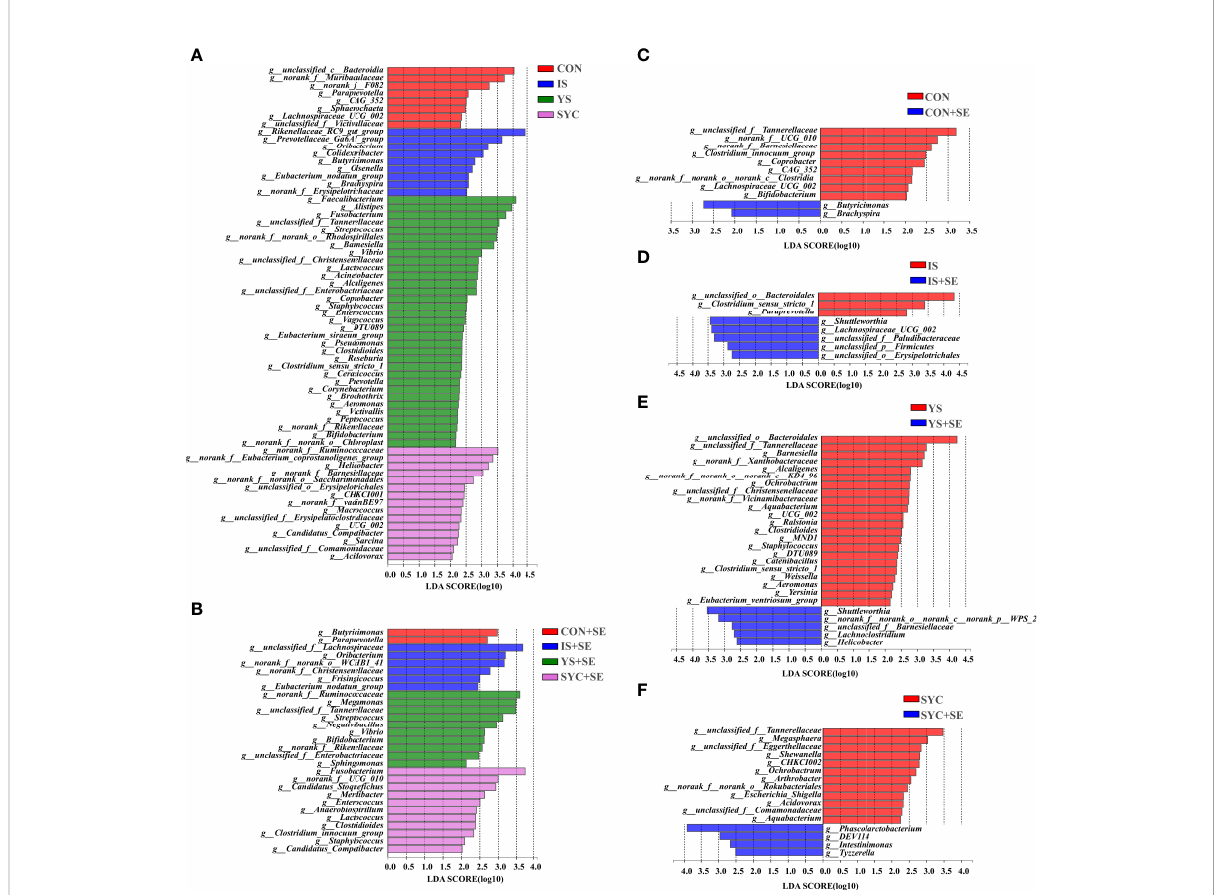
FIGURE 10 Differentially abundant genera in the gut microbiota of layers among different treatments. CON, basal diet; IS, sodium selenite; YS, yeast selenium; SYC, selenium-enriched yeast culture; CON+SE, IS+SE, YS+SE, and SYC+SE mean CON, IS, YS, and SYC challenged with S. Enteritidis , respectively. (A) LEfSe analysis of the gut microbiota in the CON, IS, YS, and SYC groups. (B) LEfSe analysis of the gut microbiota in the CON +SE, IS+SE, YS+SE, and SYC+SE groups. (C) LEfSe analysis of the gut microbiota in the CON and CON+SE groups. (D) LEfSe analysis of the gut microbiota in the IS and IS+SE groups. (E) LEfSe analysis of the gut microbiota in the YS and YS+SE groups. (F) LEfSe analysis of the gut microbiota in the SYC and SYC+SE